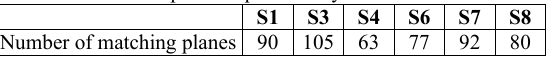
Table 6: Number of matching planes that were included in the point-to-plane analysis